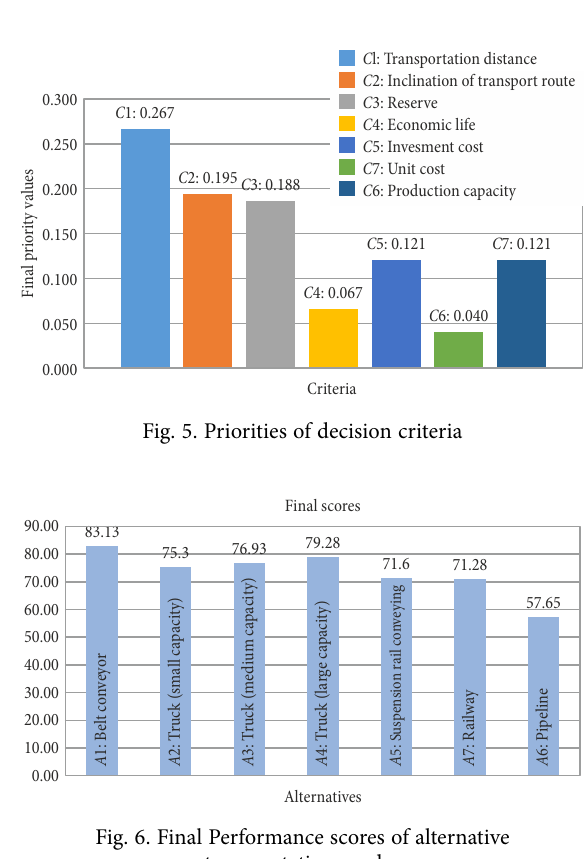
Fig. 6. Final Performance scores of alternative transportation